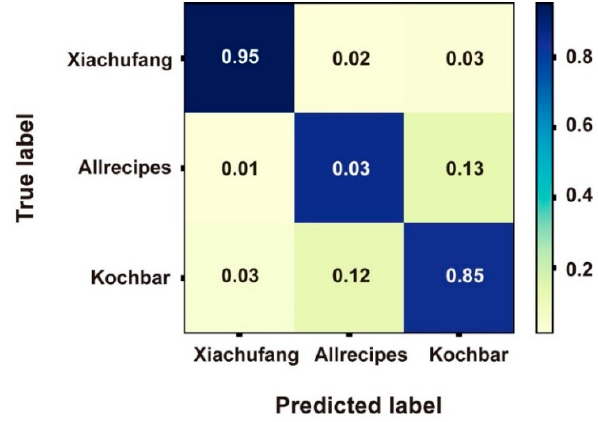
Figure 3. Confusion matrix of the best performing classifier on the samples.